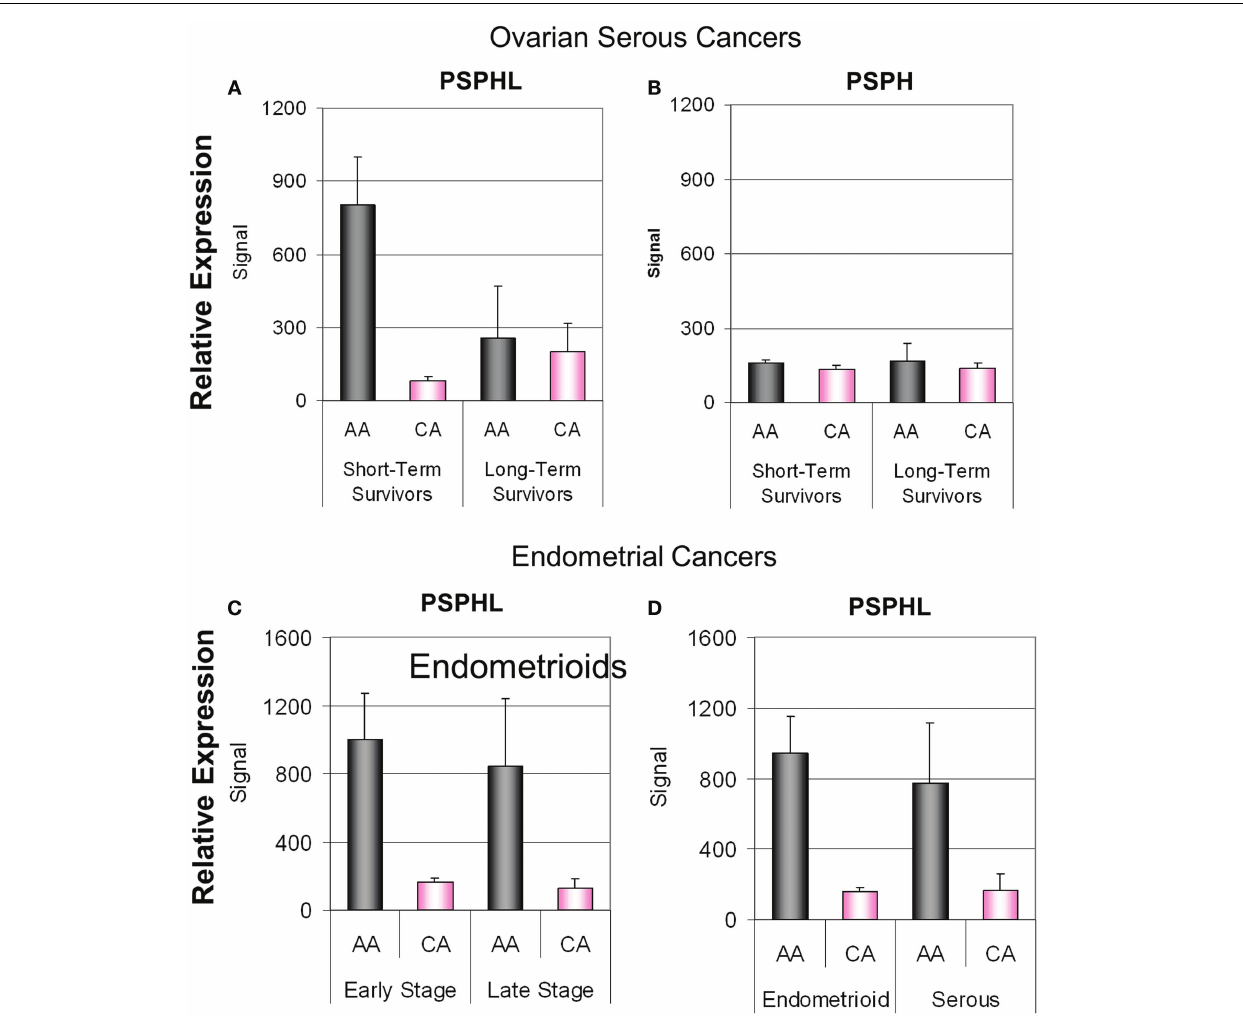
endometrial cancers: (C) by stage and (D) by histologic type. AA, African-American; CA, Caucasian; Signal, geometric average signal from Affymetrix micro